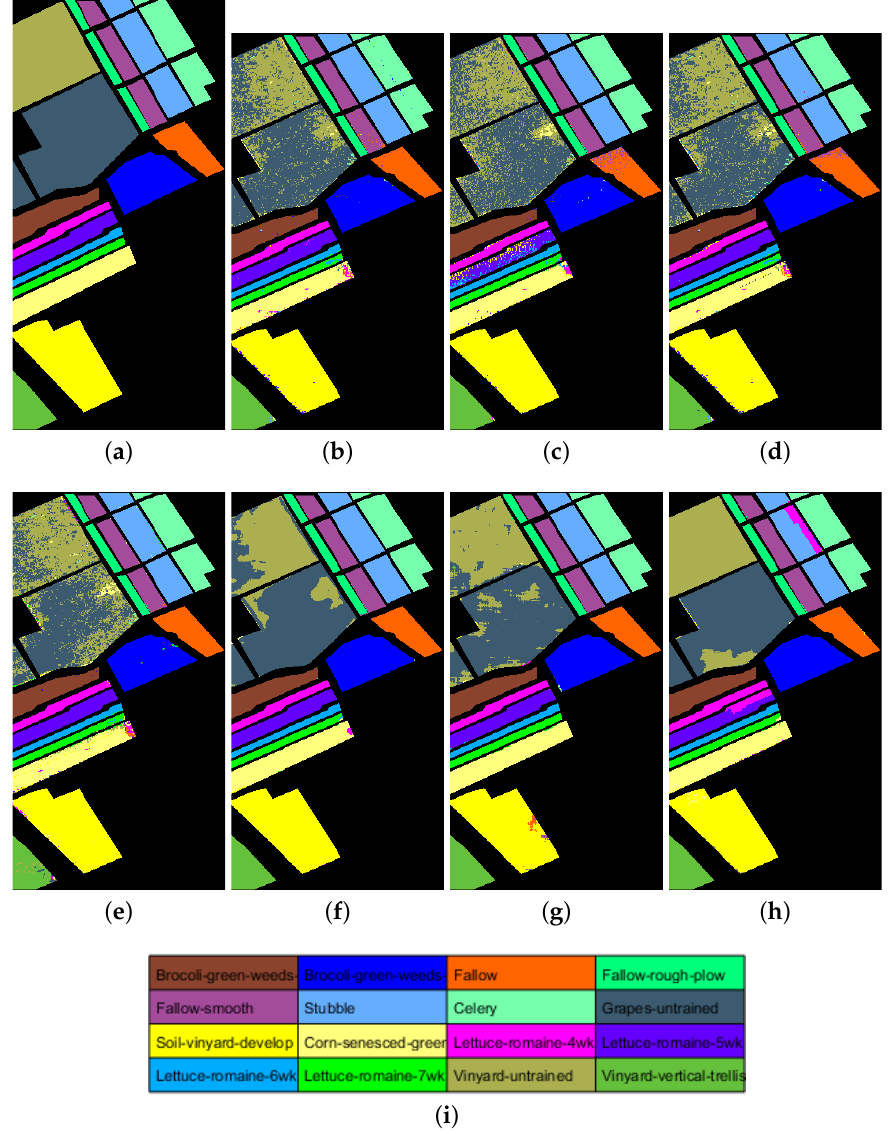
Figure 6. Classification maps of different models on the Salinas Scene dataset: ( a ) ground truth; ( b ) SVM: OA = 90.51%; ( c ) ELM: OA = 86.87%; ( d ) KELM: OA = 89.74%; ( e ) PCA-KELM: OA = 89.62%; ( f ) CK-KELM: OA = 94.46%; ( g ) LBP-KELM: OA = 95.40%; and ( h ) SP-KELM: OA = 96.90%; ( i ) Color bars for land